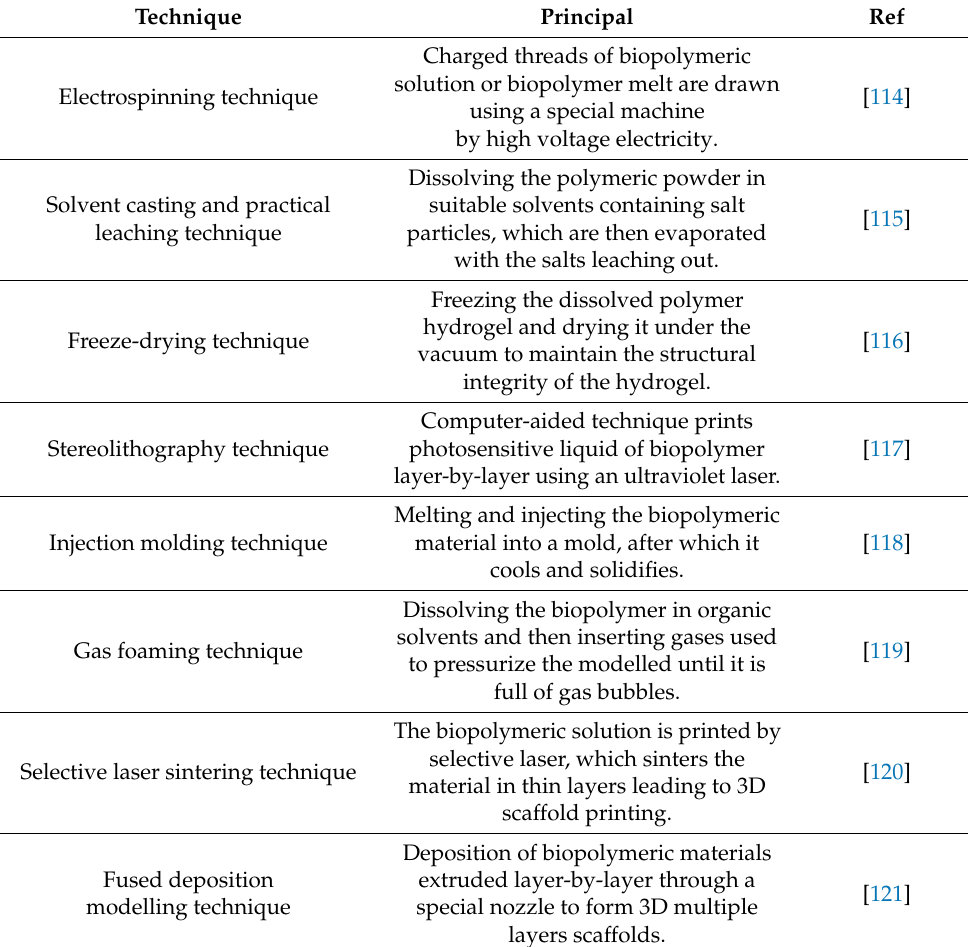
Table 3. Summary of the most used techniques for biopolymer aerogel scaffold